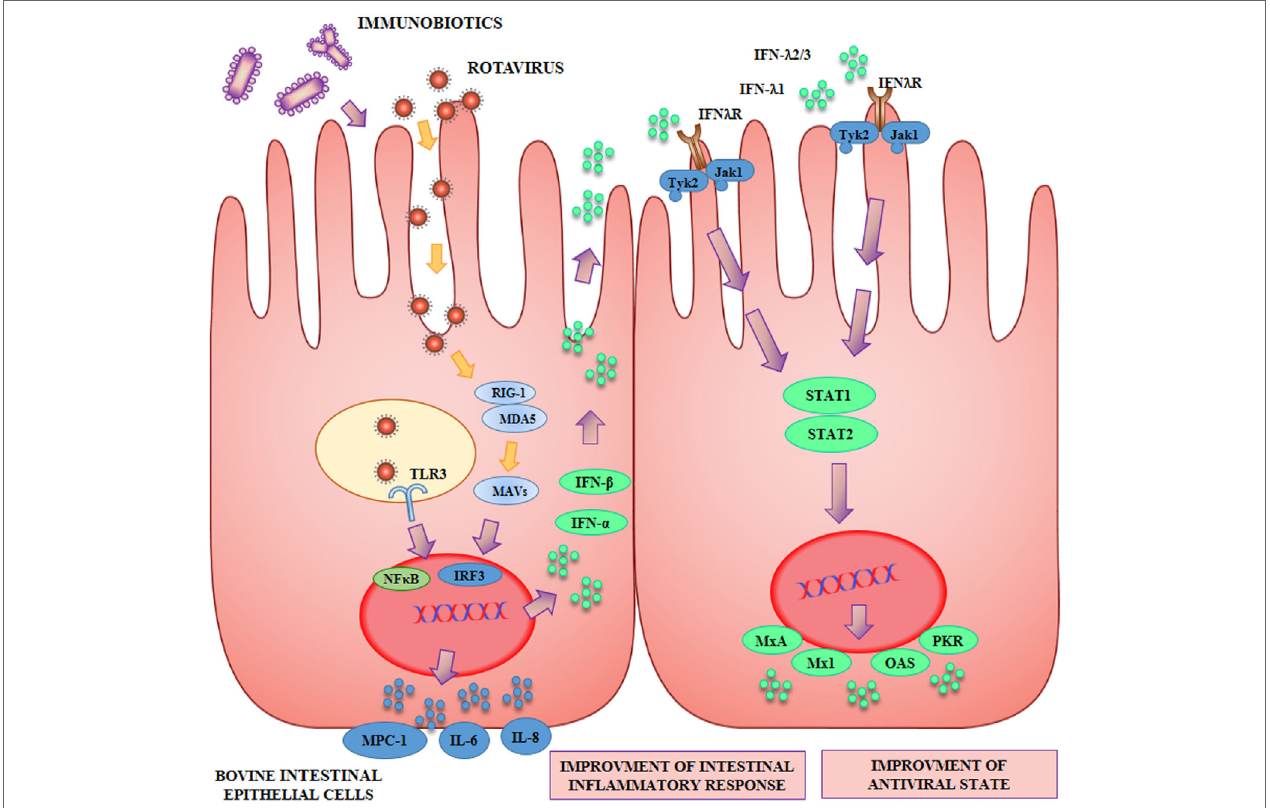
FiGURe 2 | Beneficial effects of immunobiotics on the antiviral innate immune response against rotavirus in bovine intestinal epithelial (BIE) cells. Rotavirus doublestranded genomic RNA activates toll-like receptor 3 (TLR3), retinoic acid inducible gene-I (RIG-I), and melanoma differentiation-associated gene-5 (MDA-5), which are pattern recognition receptors (PRRs) expressed in IECs. Cellular signaling cascades mediated by interferon (IFN) regulatory factor-3 (IRF3) upregulate the expression of type I (IFN- α , IFN- β ), and type III (IFN λ 1, IFN λ 2/3) IFN, which in turn induces the synthesis of IFN-stimulated genes with antiviral activities including: myxovirus resistance 1 IFN-inducible protein (Mx1), MxA, ribonuclease L (RNaseL), 2 ′ -5 ′ -oligoadenylate synthetase (OAS), and protein kinase R (PKR). Antiviral PRRs also activate nuclear factor κ B (NF- κ B) pathway and induce the secretion of proinflammatory cytokines and chemokines including: interleukin 6 (IL-6), IL-8, monocyte chemotactic protein 1 (MCP-1/CCL2), and IFN gamma-induced protein 10 (IP-10/CXCL10). Preventive treatment of BIE cells with immunobiotics increase the activation of IRF3, improve the production of the antiviral factors and differentially regulate the expression of inflammatory